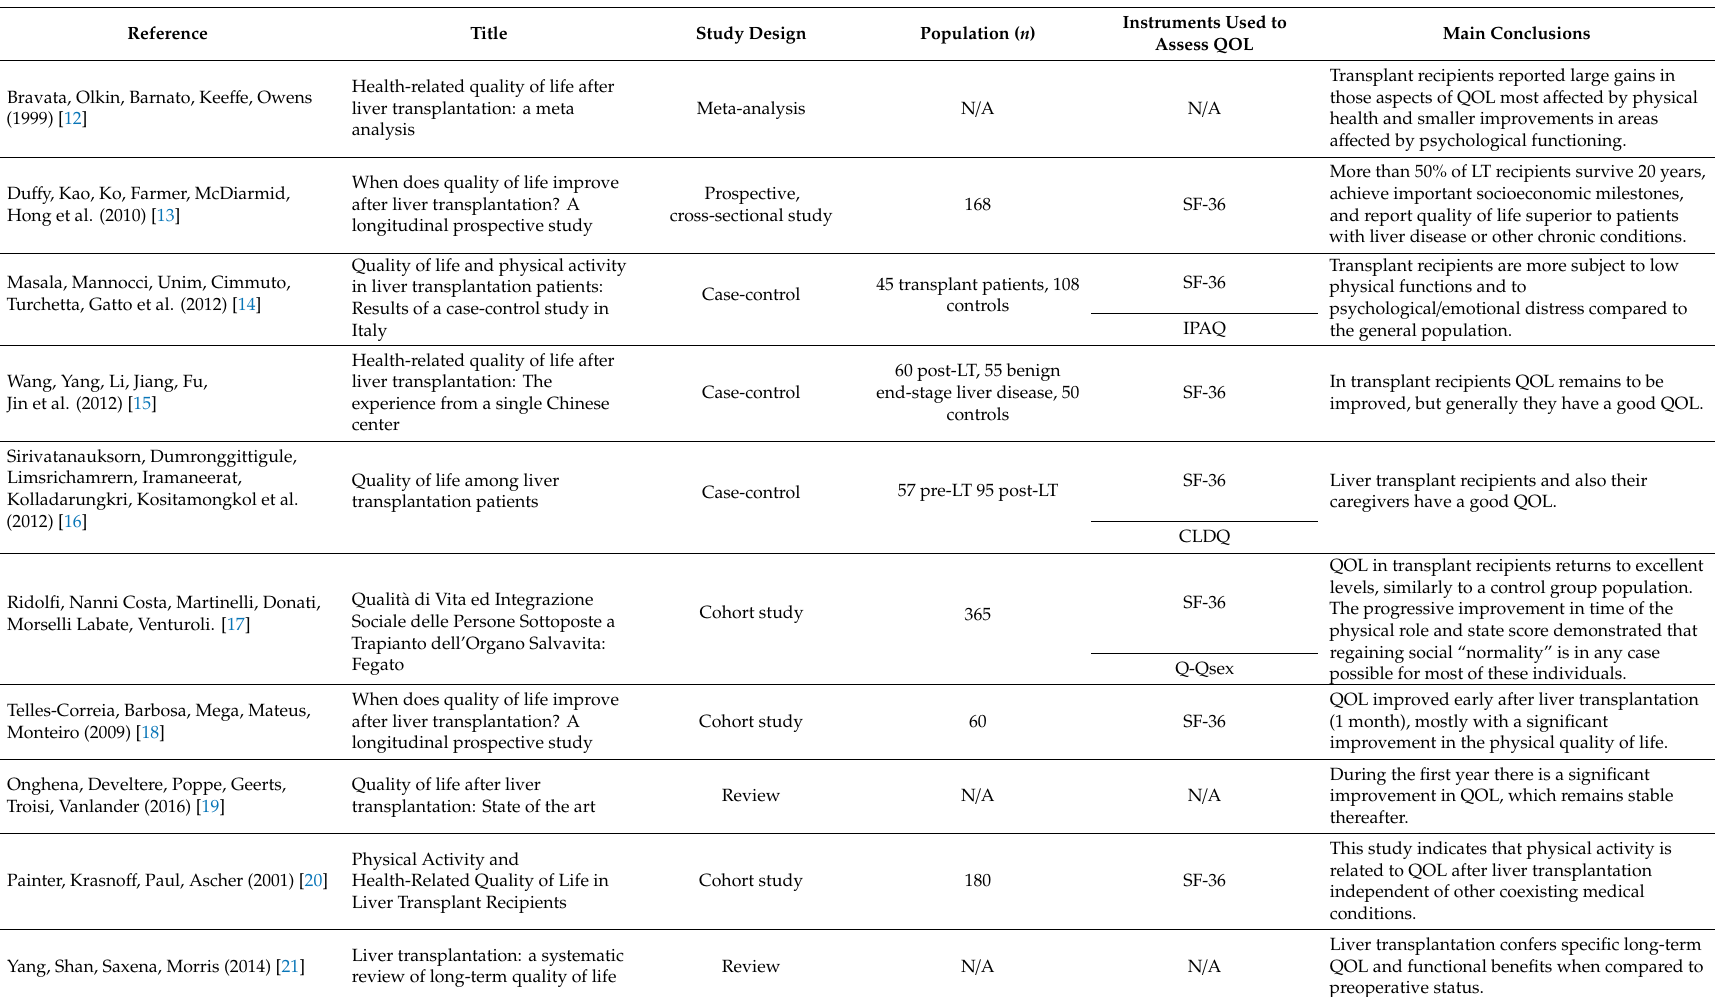
Table 4. Main studies on quality of life (QOL) and liver